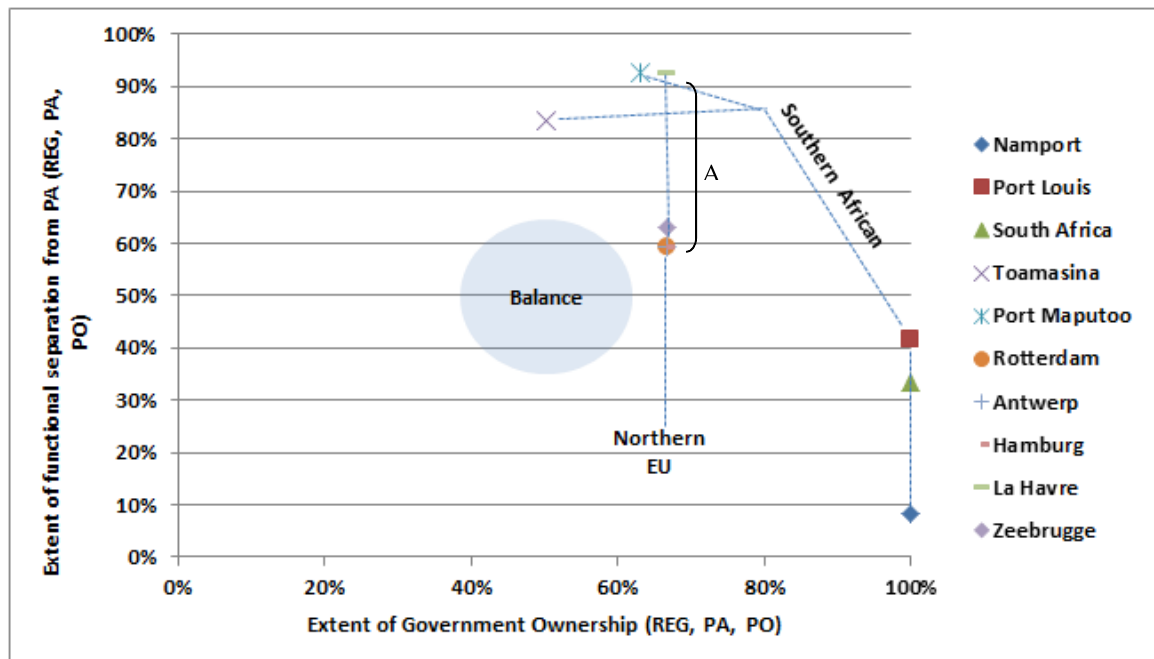
Figure 7. SA & EU-HL Port Institutional Positioning